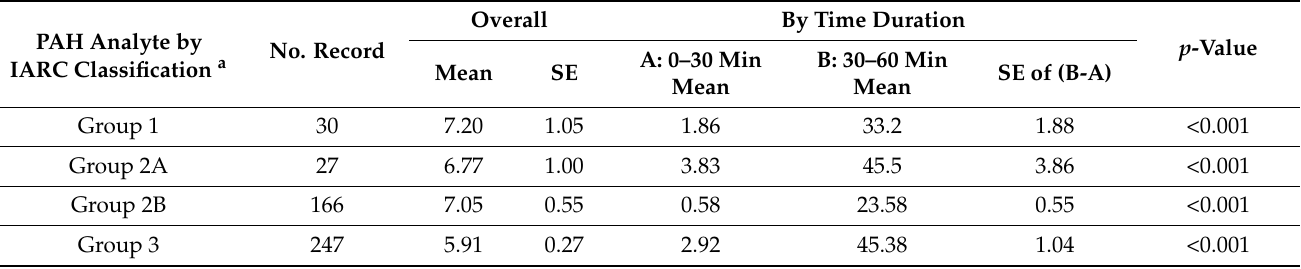
Table 4. Collection time and PAH (AM) from air on personal equipment by IARC group (unit: µ g/m 3 ). Bold p -values indicate statistically significant increases in PAH concentrations with time. PAH Analyte by IARC Classification